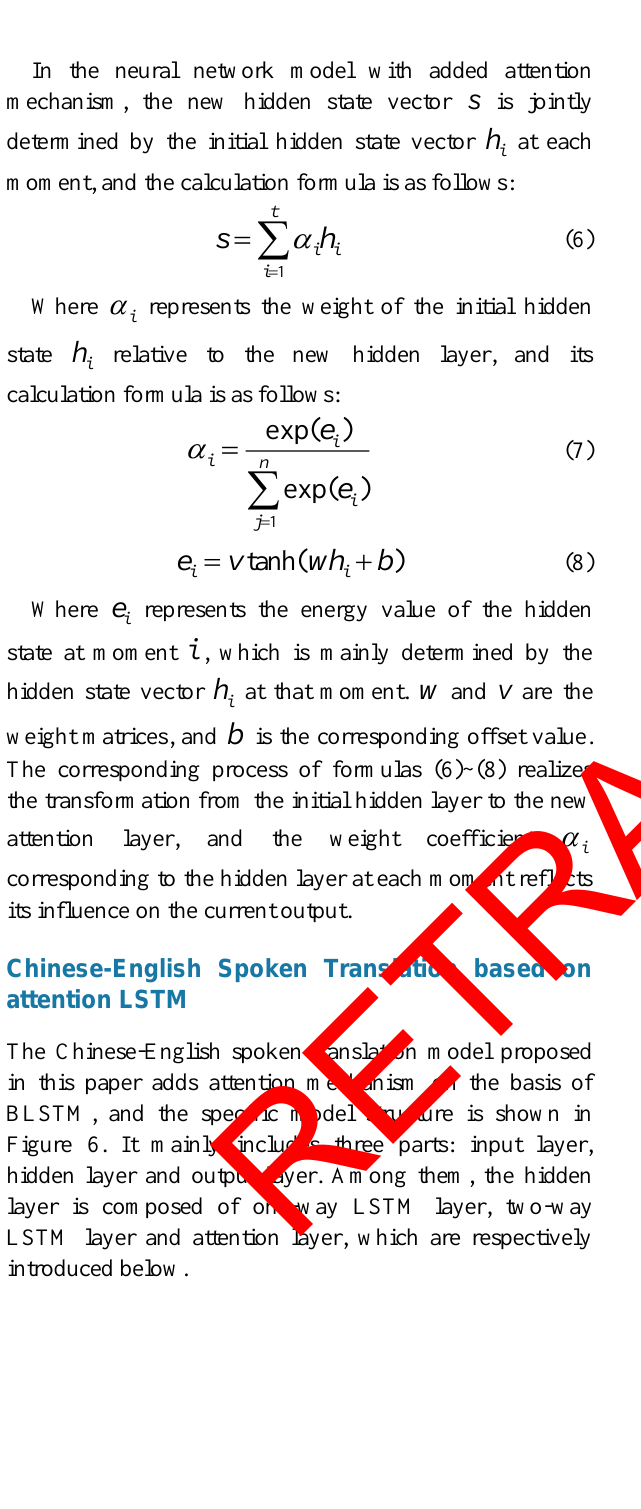
Figure 5. Structure of attention model